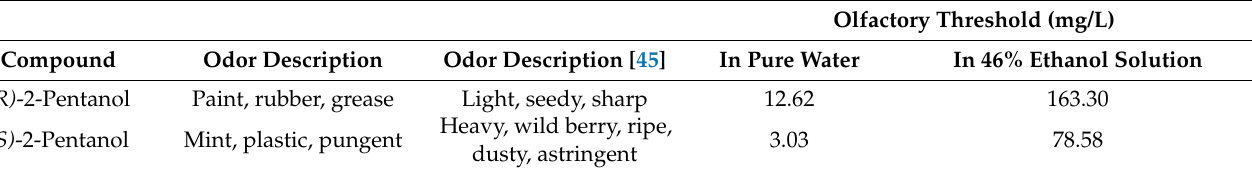
Table 6. Odor description and olfactory thresholds of 2-pentanol